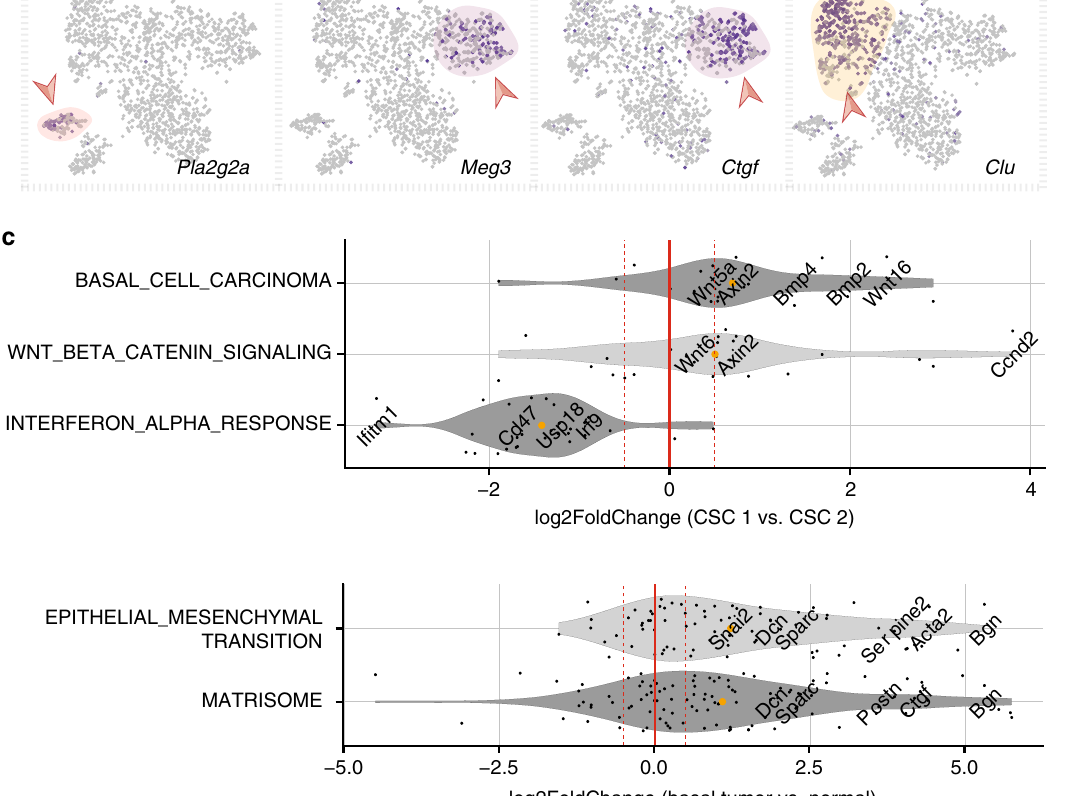
Fig. 4 Subclustering reveals additional heterogeneity in cancer stem cell-like and basal cells. a Subclustering of the tumor-speci fi c epithelial subset identi fi es two cancer stem cell-like ( ‘ CSC 1 ’ and ‘ CSC 2 ’ ) and two basal cell ( ‘ basal normal ’ and ‘ basal tumor ’ ) subpopulations. b Expression of several genes in the subclustered tumor-speci fi c tSNE representation as indicated by a color scale ranging from gray (no expression) to dark blue (high expression) with regions of high expression highlighted. c Gene set enrichment analysis on differentially expressed genes between CSC-like or basal subclusters, respectively. Shown are log2 fold changes for all genes per pathway expressed in at least 5% of cells, with selected genes highlighted. Orange dots indicate the pathway mean, dashed lines the cutoff set on the pathway